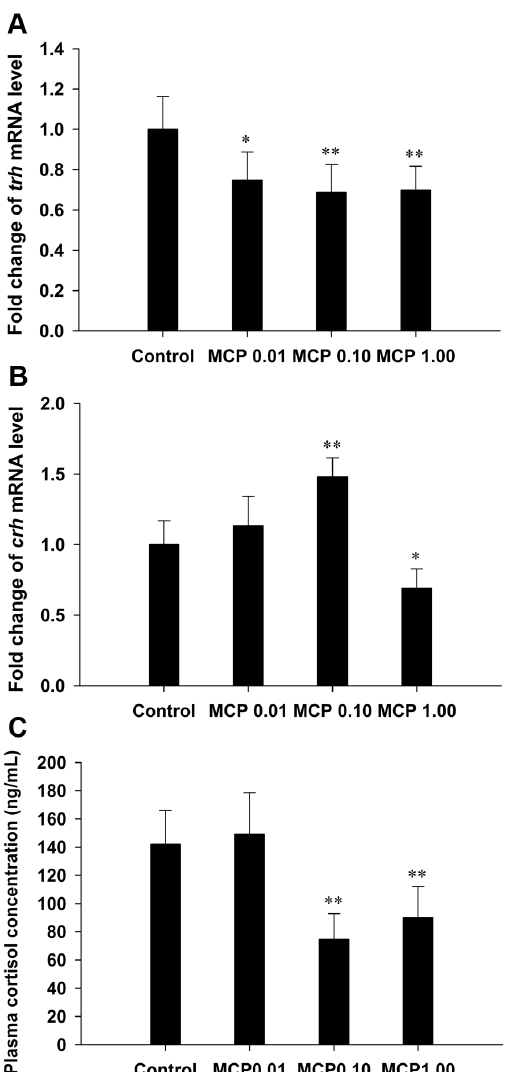
Figure 5. Relative mRNA expression levels of thyrotropin- releasing hormone ( trh ) and corticotrophin-releasing hormone ( crh ) in the hypothalamus glands and quantification of plasma cortisol content in female goldfish exposed to 0, 0.01, 0.10, and 1.00 mg/L 40% monocrotophos (MCP) pesticide. (designat- ed C, MCP0.01, MCP0.10, and MCP1.00, respectively). For panels A and B, fold change (Y axis) represents the expression of the target gene mRNA relative to that of the control group (equals 1 by definition). The data are presented as the means 6 standard deviations (n=9). Asterisks indicate statistically significant differences from the control group (*0.01 , P , 0.05, ** P , 0.01).